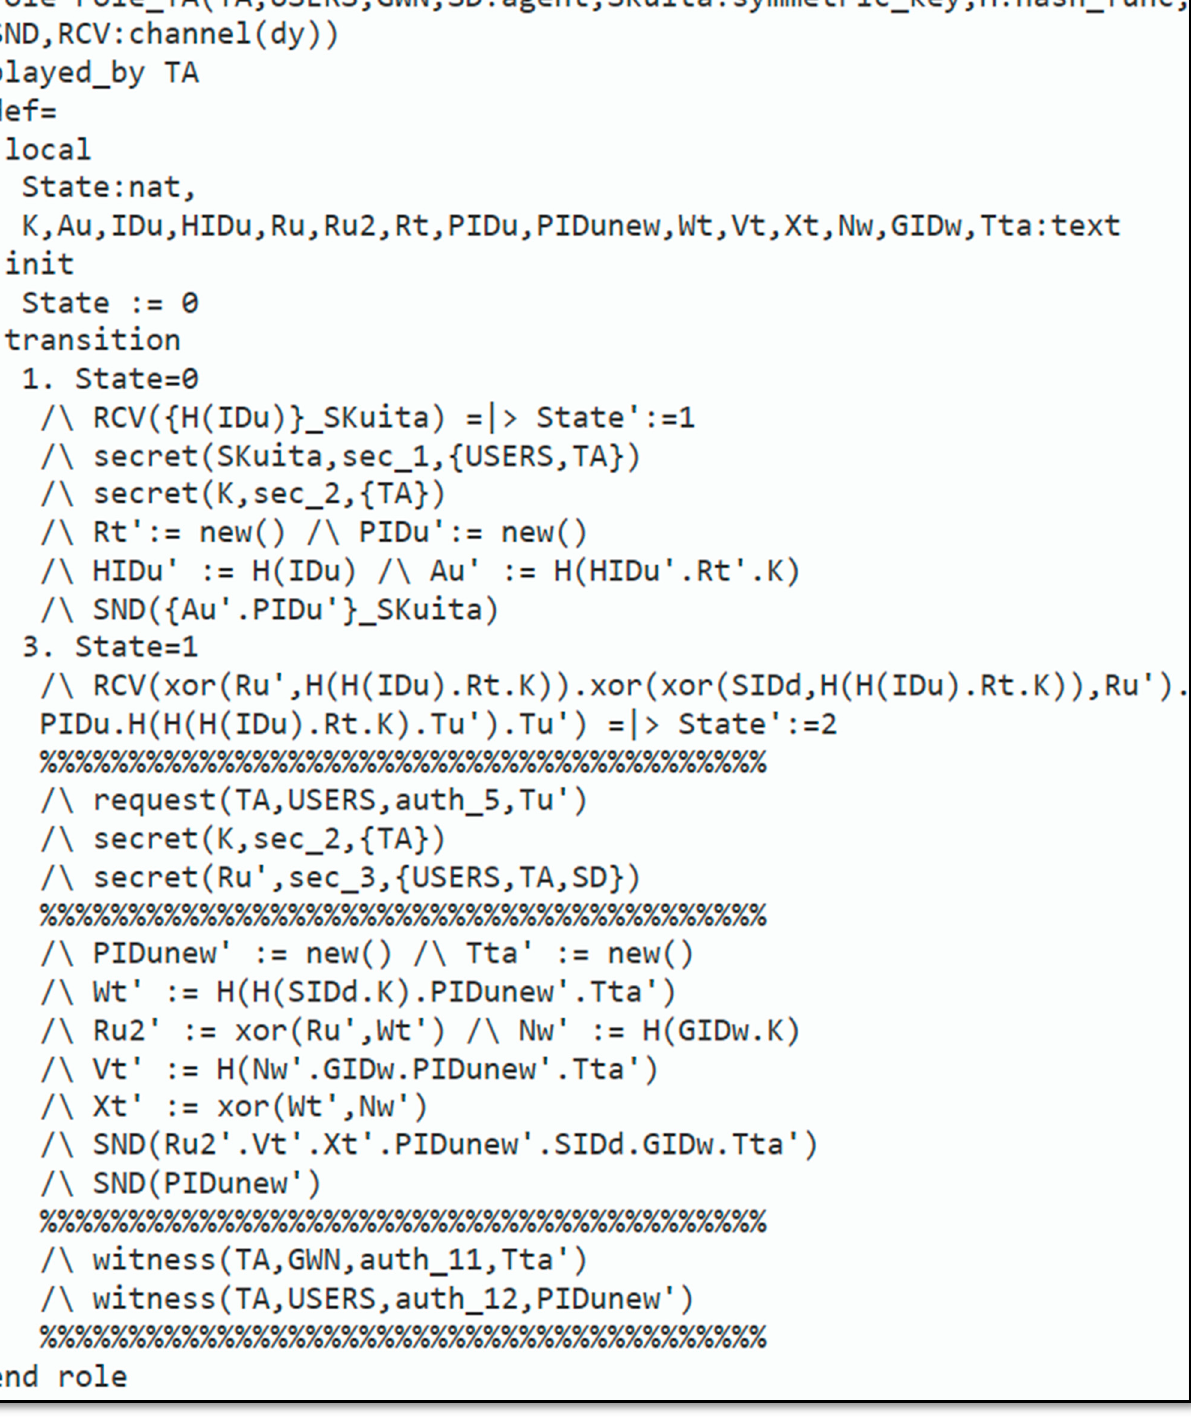
Figure 5. Role specification for TA.